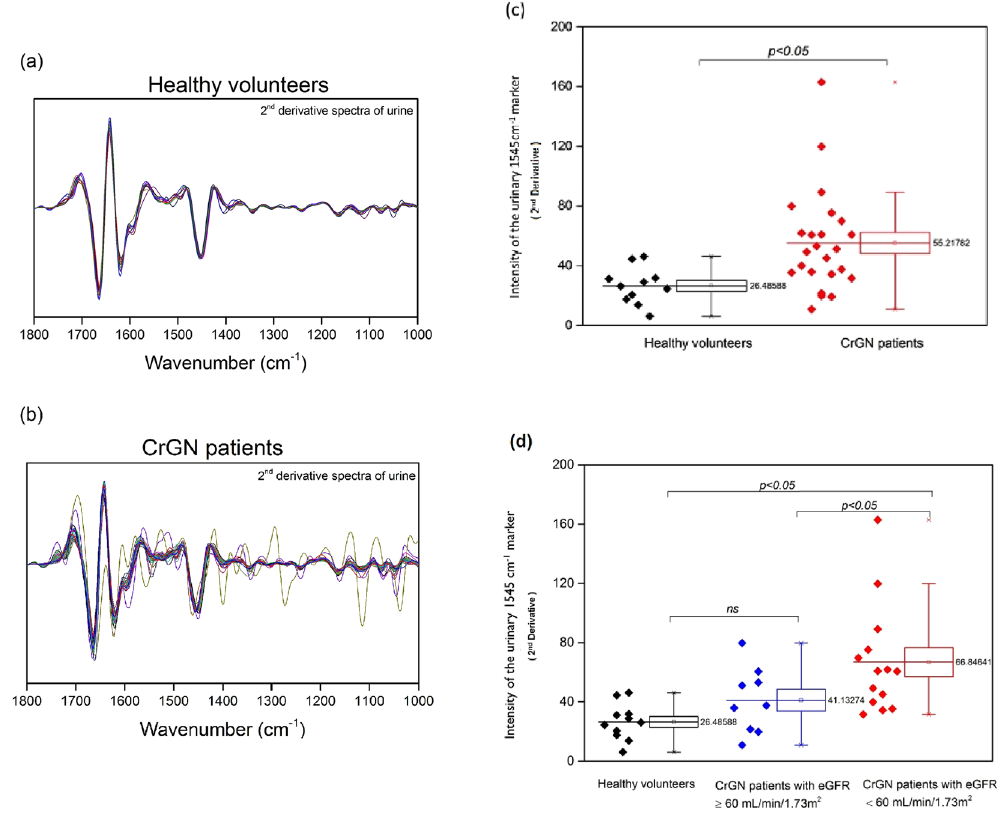
Figure 9. Comparison of FTIR urine spectra of patients with crescentic glomerulonephritis (CrGN) with those from healthy volunteers. The normalized 2 nd derivative spectra of urine of ( a ) healthy volunteers (n = 11) and ( b ) CrGN patients (n = 24) are shown. The 1545 cm − 1 band was significantly higher in CrGN patients [ p < 0.05, graph ( c )]. ( d ) The intensity of the 1545 cm − 1 band is significant higher in patients with severe/moderate CrGN patients (eGFR < 60 ml/min/1.73 m 2 ) than in both healthy volunteers and mild CrGN patients (eGFR ≥ 60 ml/ min/1.73 m 2 ). (The data are expressed as mean ± SD as determined by sample t test or one-way ANOVA with Fisher’s LSD post hoc